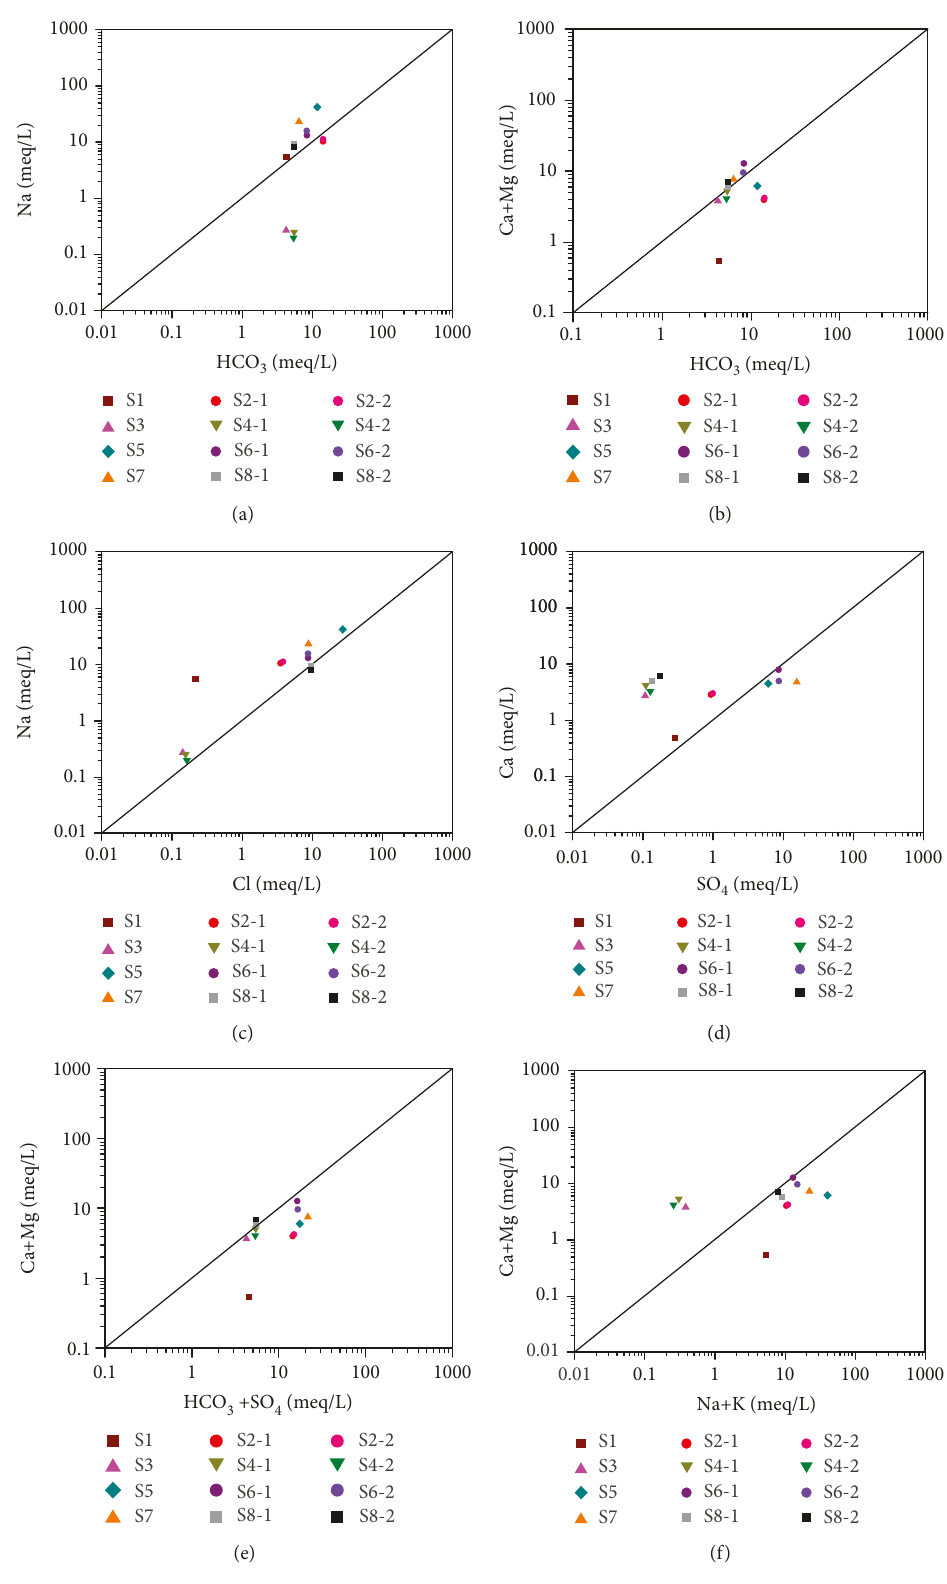
Figure 6: Relationship between major constituents in the springs in the Simao Basin: (a) Na vs. HCO (d) Ca vs. SO ; (e) Ca+Mg vs. HCO 4